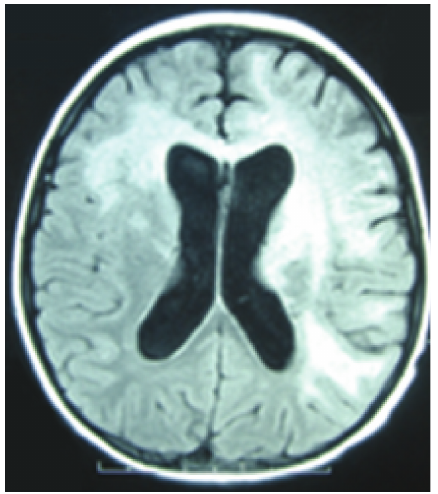
Figure 1: CT on day 30 of onset of symptoms and 1week post- HAART initiation. Figure 2: MRI on day 38 of onset of symptoms and 2weeks post- HAART